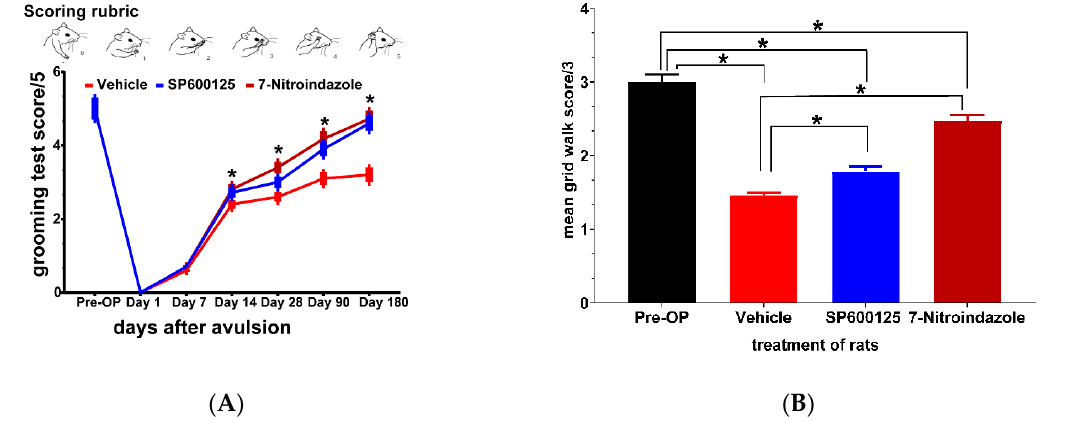
Figure 8. Neuroprotective treatments enhance recovery of forelimb function after ventral spinal root avulsion. ( A ) Positions of the forelimbs and corresponding scores (0–5) of the Terzis grooming test; ( B ) grid walk test scores for evaluating impairment in runway crossing. Data are expressed as the mean ± SD ( n = 4 in each group). For the grooming and grid walk tests * p < 0.05, Kruskal Wallis test followed by the Tukey post hoc test was used to compare multiple groups (vehicle versus SP600125 or 7-nitroindazole and SP600125 versus 7-nitroindazole).